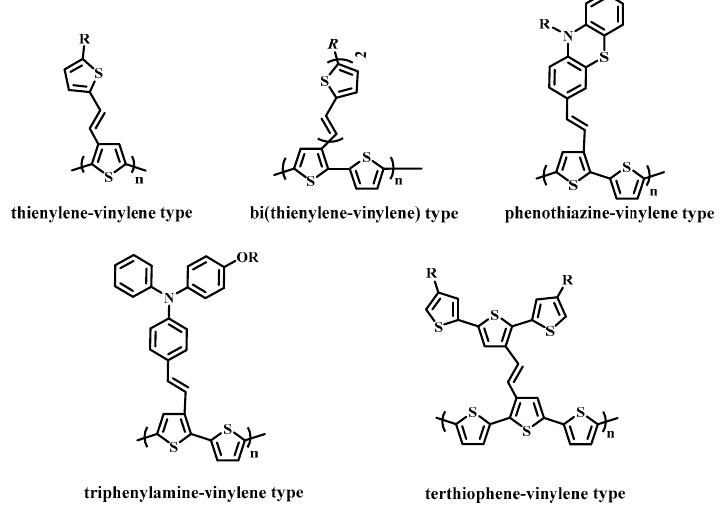
Figure 1. Molecular structures of the 2-D conjugated polythiophene derivatives (R = alkyl group)